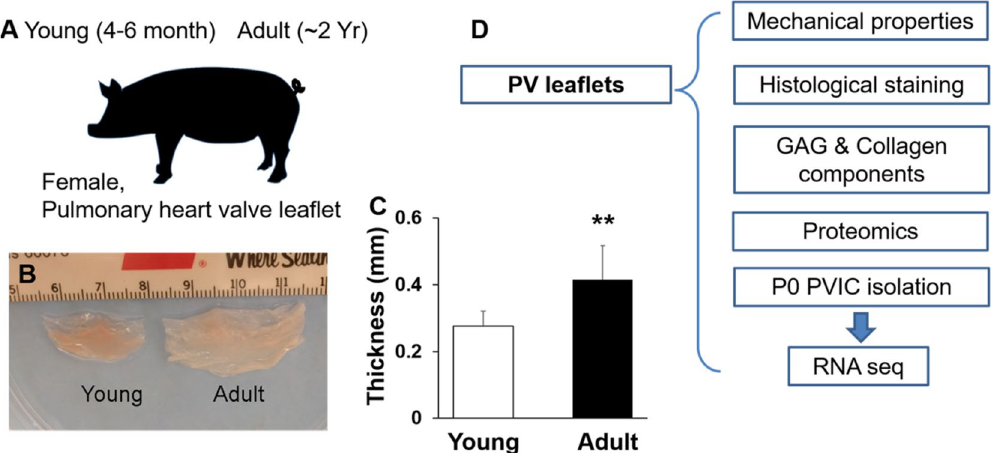
Figure 1. Isolation of porcine PV leaflets and experimental design. ( A ) PV leaflets were isolated from female pigs with ages of 4–6 months and 2 years (denoted as young and adult, respectively). ( B ) isolated PV leaflets from young and adult pigs; ( C ) thickness of young and adult PV leaflets (measured around free edge of valve cusp, 5 PV leaflets from three pigs for each age group were used, **p < 0.01); ( D ) schematic illustration